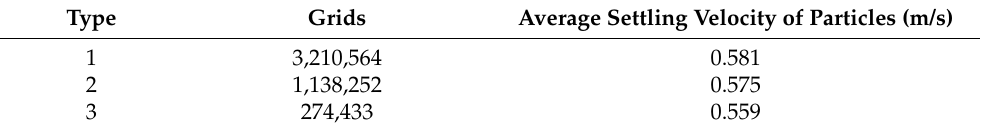
Table 4. Grid independence